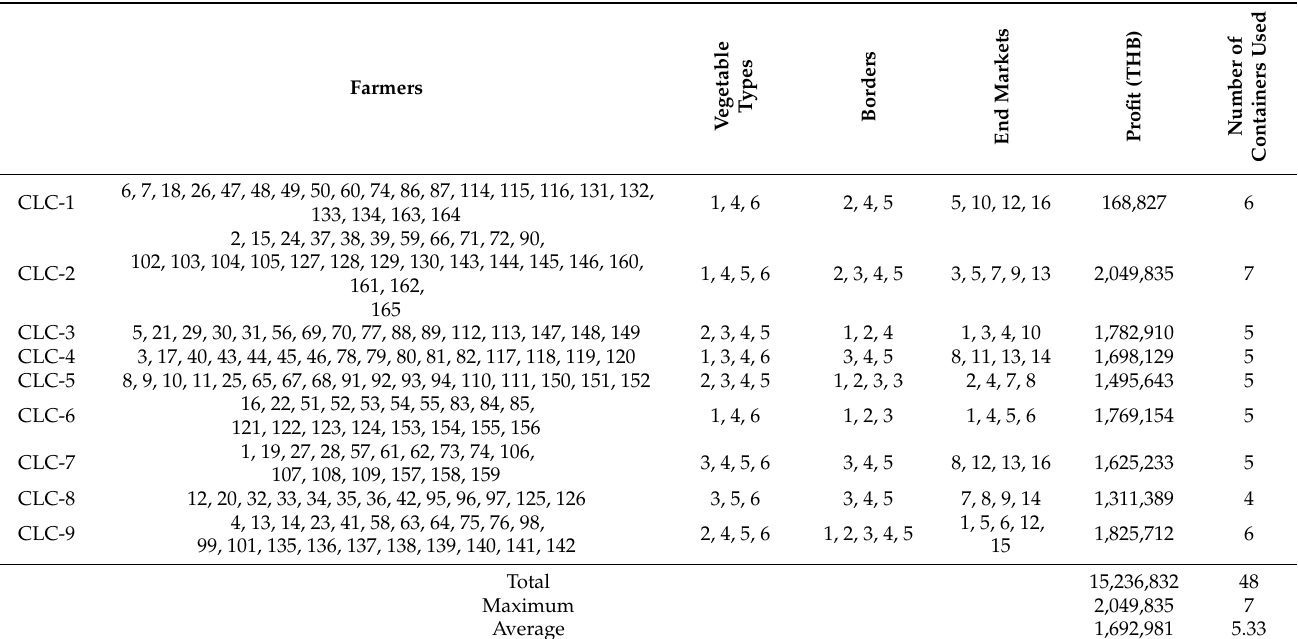
Table 23. Computational results of the case